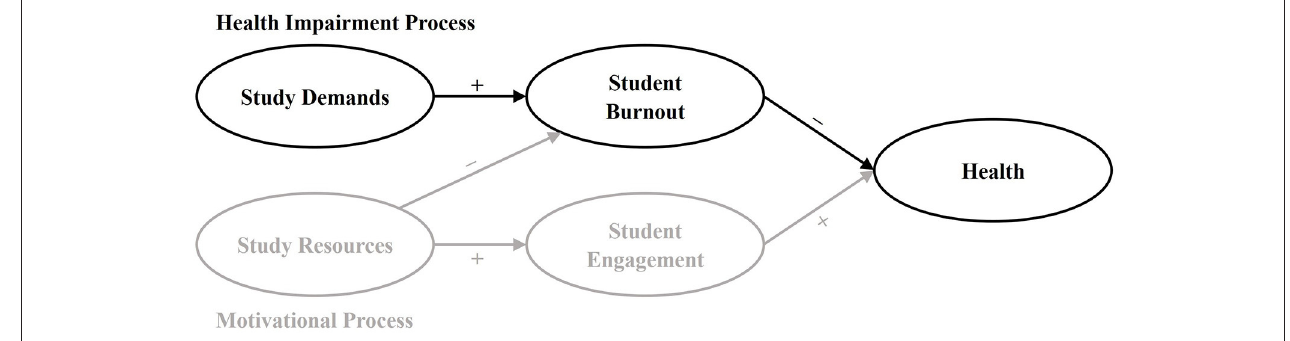
FIGURE 1 | The study demands-resources (SD-R) framework.